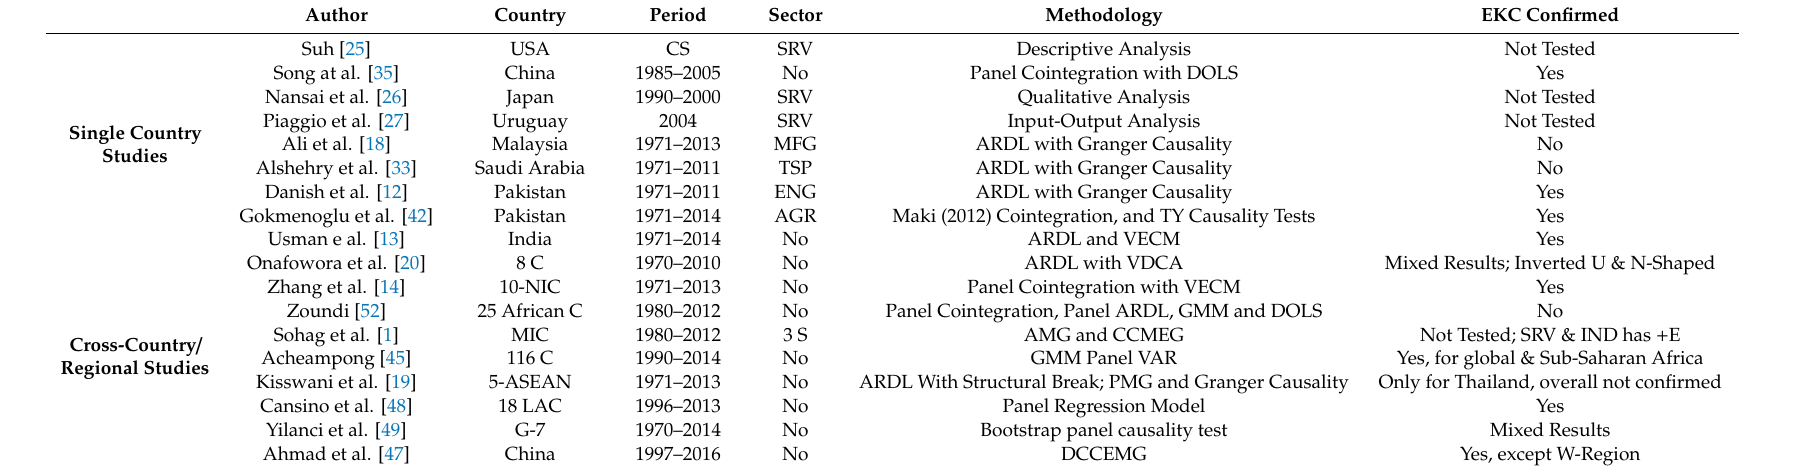
Table 1. Snapshot of selected EKC